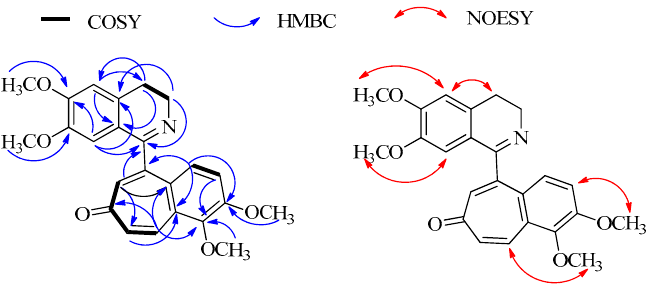
Figure 2. Key COSY, HMBC and NOESY correlations of mahimbrine A.